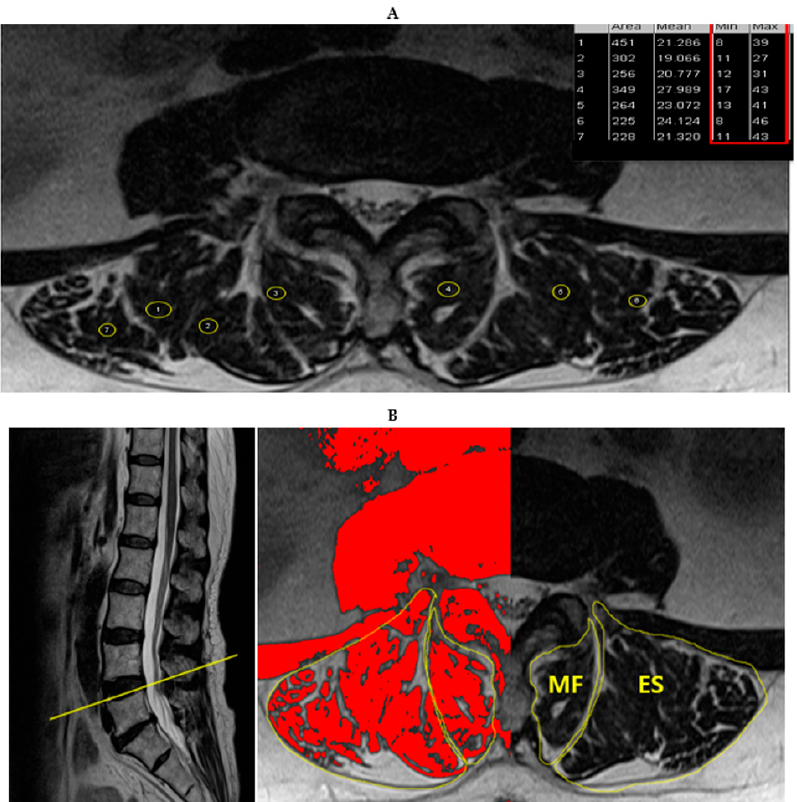
Figure 2. Quantitative paraspinal muscle measurement. Measurement of cross-sectional area (CSA) and functional CSA of the multifidus muscle (MF) and erector spinae (ES) muscle at the L4-L5 disk level. ( A ) Sample selection of regions of interest (ROIs) to define upper and lower signal intensity threshold limits. ( B ) Sagittal and axial T2 weighted MR image of the FCSA of the paraspinal muscle group (red area), using the threshold method with ROI tracing.